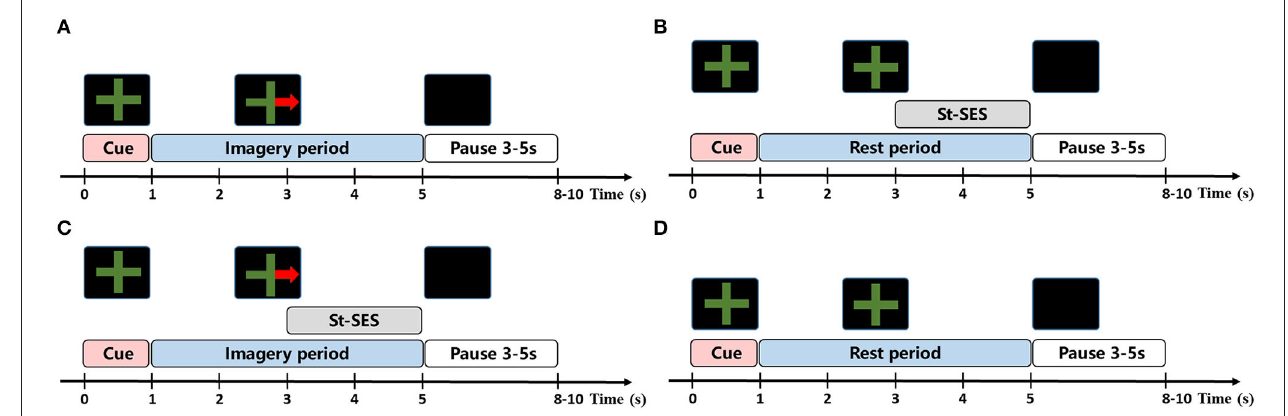
FIGURE 1 | The task procedure of experimental condition. (A) MI condition. In each trial of MI condition, the subjects were required to perform MI task according to the cue. (B) SES condition. In each trial of SES condition, the subjects were asked to remain at rest and received st-SES intervention. (C) MI-SES condition. In each trial of MI-SES condition, the subjects were instructed to perform MI task according to the cue and st-SES was applied to subjects during MI. (D) Rest condition. In each trial of Rest condition, the subjects were asked to remain